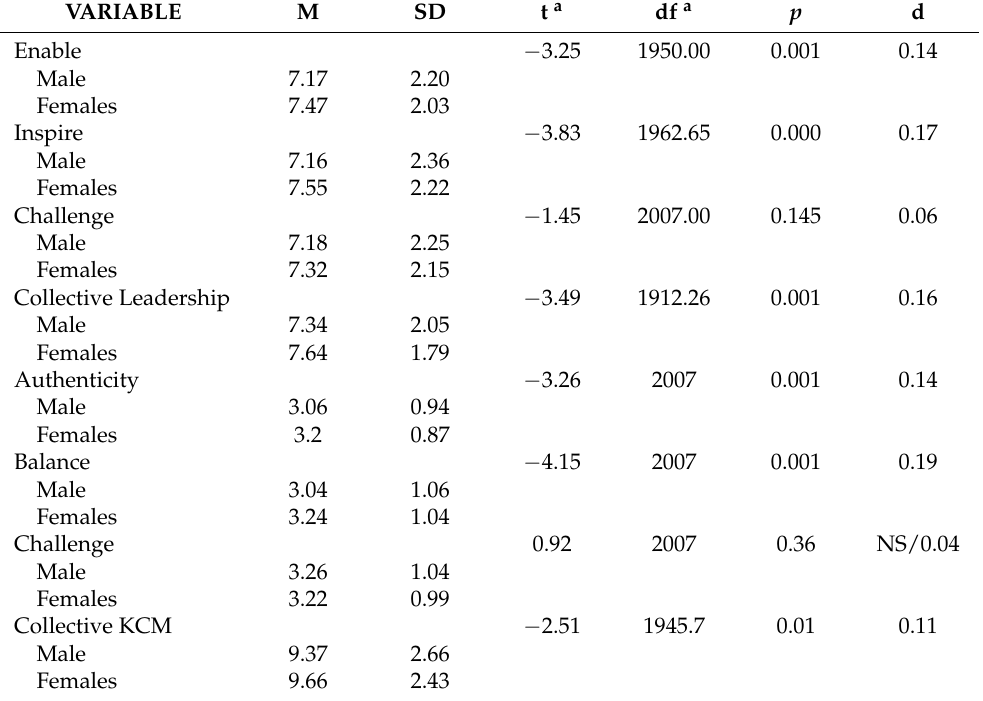
Table 3. Comparison of Male and Female Respondent Responses on Leadership Practices Study